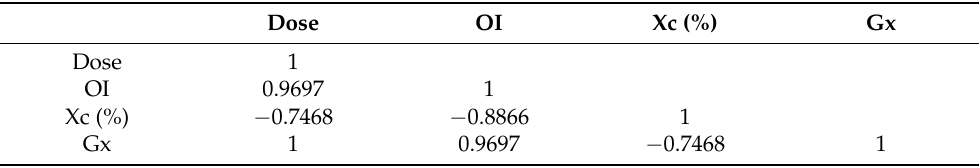
Table 5. Correlation matrix of pristine unirradiated and irradiated UHMWPE for in-depth investiga- tion of the correlation of radiation dose with OI, Xc (%), and Gx.